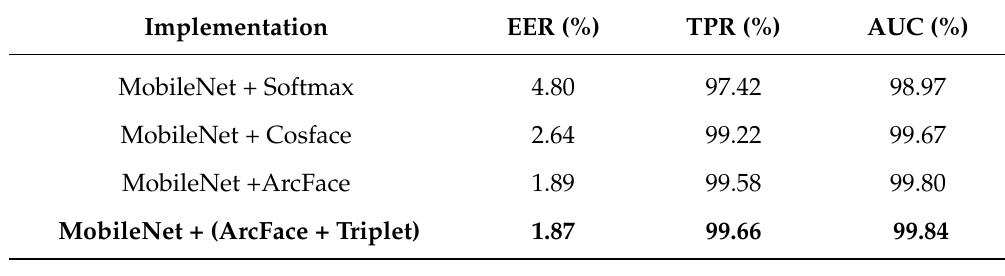
Table 3. Testing results of different implementation on CASIA-Iris-Thousand.